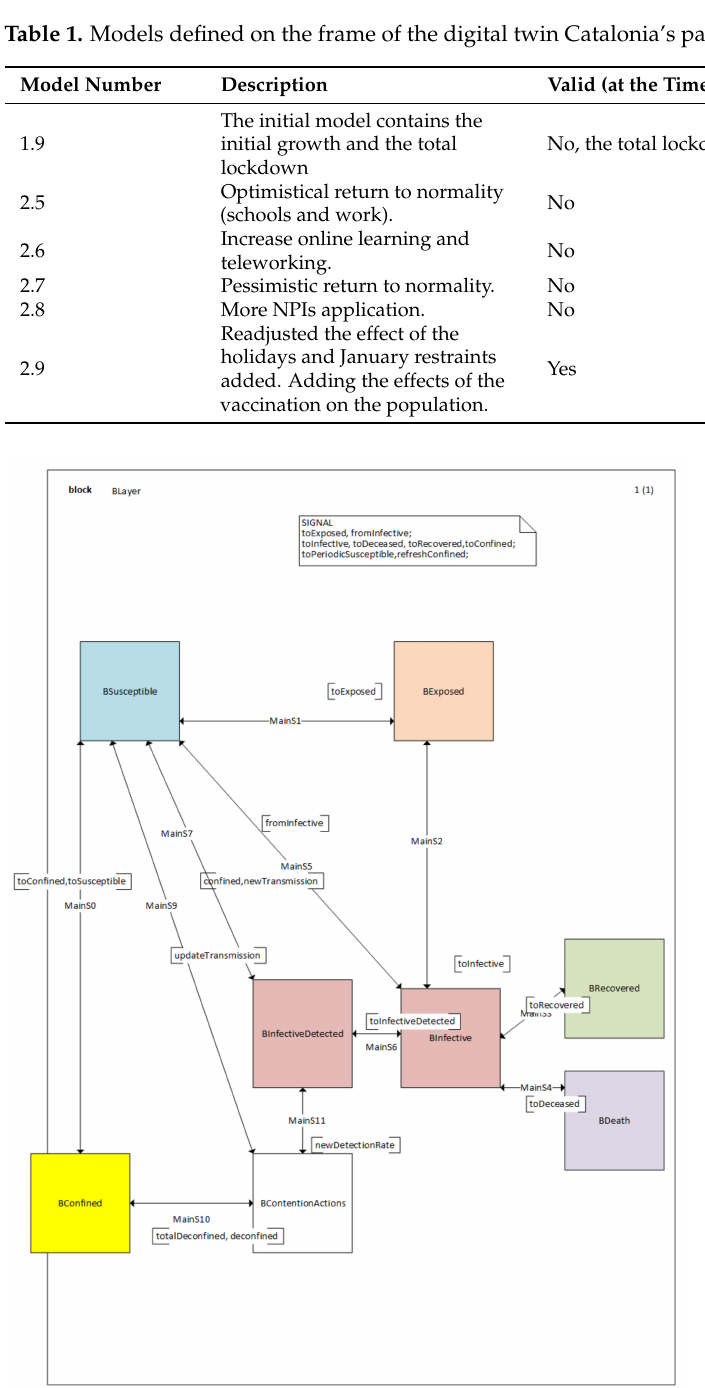
Figure 4. SDL 2.5 model. Each color on the diagram represents a Compartment on the original SEIRD model (using the same colors). The exception is for the BContentionActions BLOCK that represents the different NPIs applied. Notice that BInfectiveDetected and BInfective refer to the single Infective compartment on the initial SEIRD model because on the SDL 2.5 version model, we can distinguish between real and detected cases. Notice that the 1(1) in the upper corner defines the number of pages that detail this diagram and the current page